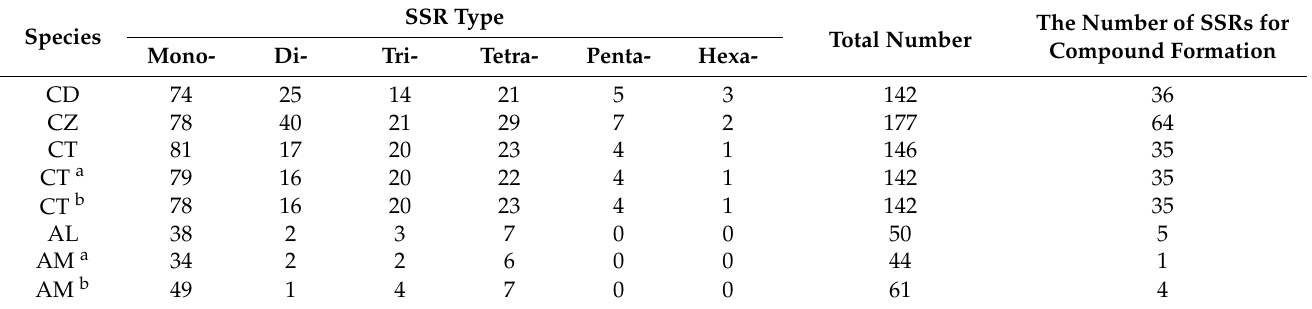
Table 3. Number of SSRs in the chloroplast genomes of three Ceriops and two Avicennia